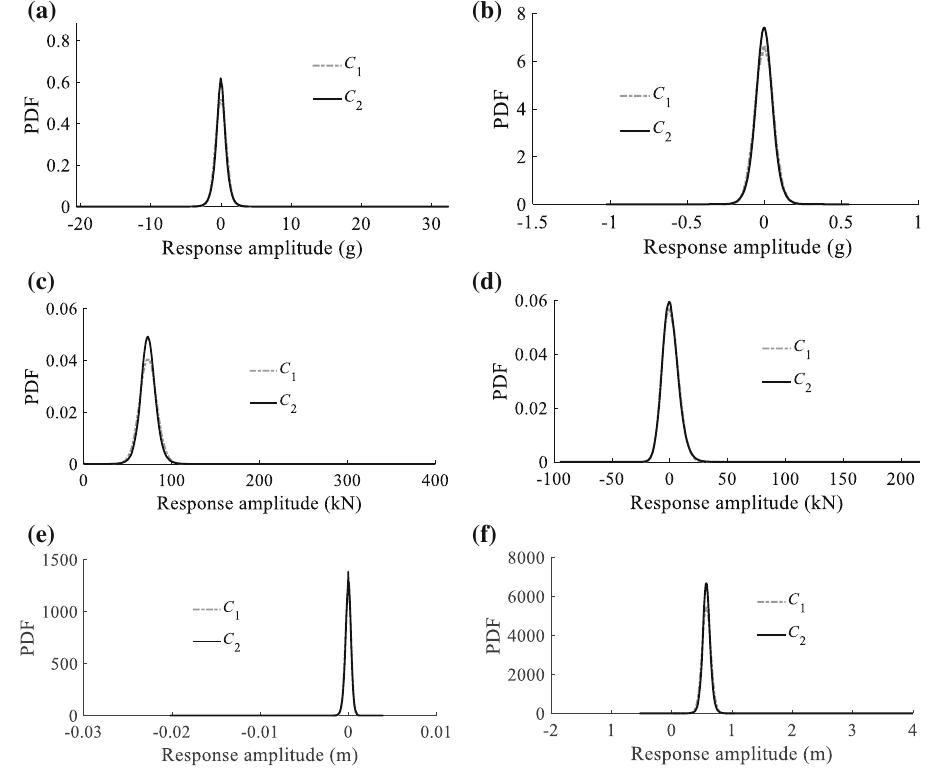
Fig. 11 PDF comparison between excitation types C 1 and C 2 ( a vertical acceleration of the bogie frame; b lateral acceleration of the wheelset; c wheel–rail vertical force; d wheel–rail lateral force; e rail lateral displacement; f rail vertical